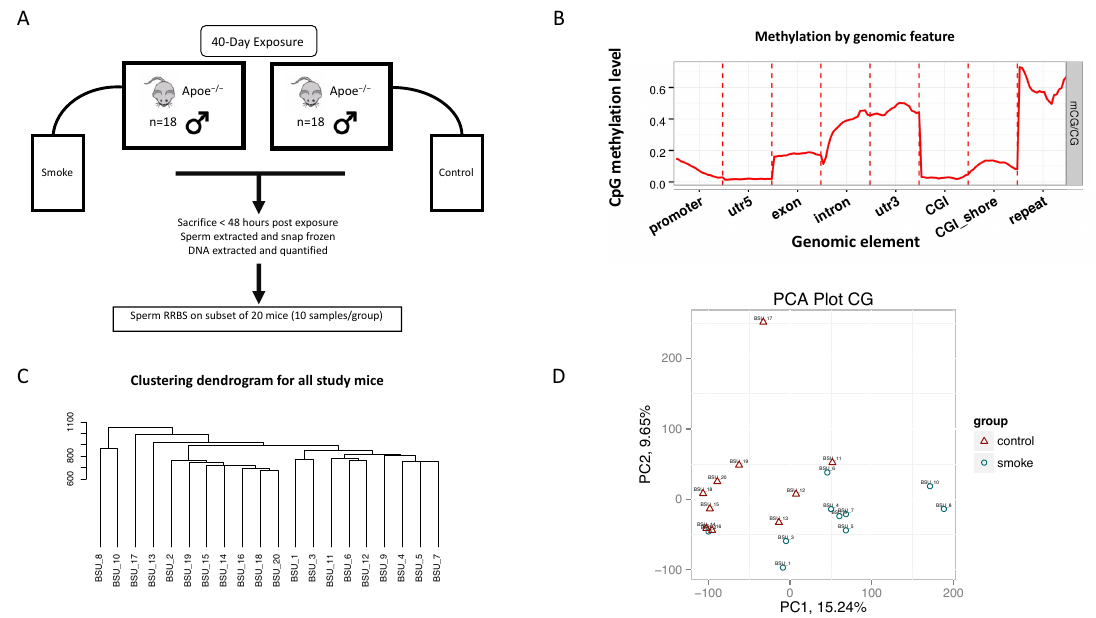
Figure 1. Schematic of study design and DNA methylation characteristics. ( A ) Study design showing exposure group, study duration and health outcome of interest. ( B ) An example of the average methylation level distribution in genomic functional regions for one of the samples is shown to demonstrate general agreement with our understanding of methylation profiles (i.e., promoter methylation is relatively low, while repeat elements are highly methylated). ( C ) The dendrogram shows the hierarchical clustering of the study mice. ( D ) PCA plot for principal components 1 and 2. Panels C and D demonstrate the relationship between samples, which is mostly dichotomous by exposure group, where IDs “BSU 1–10” are exposed and “BSU 11–20” are